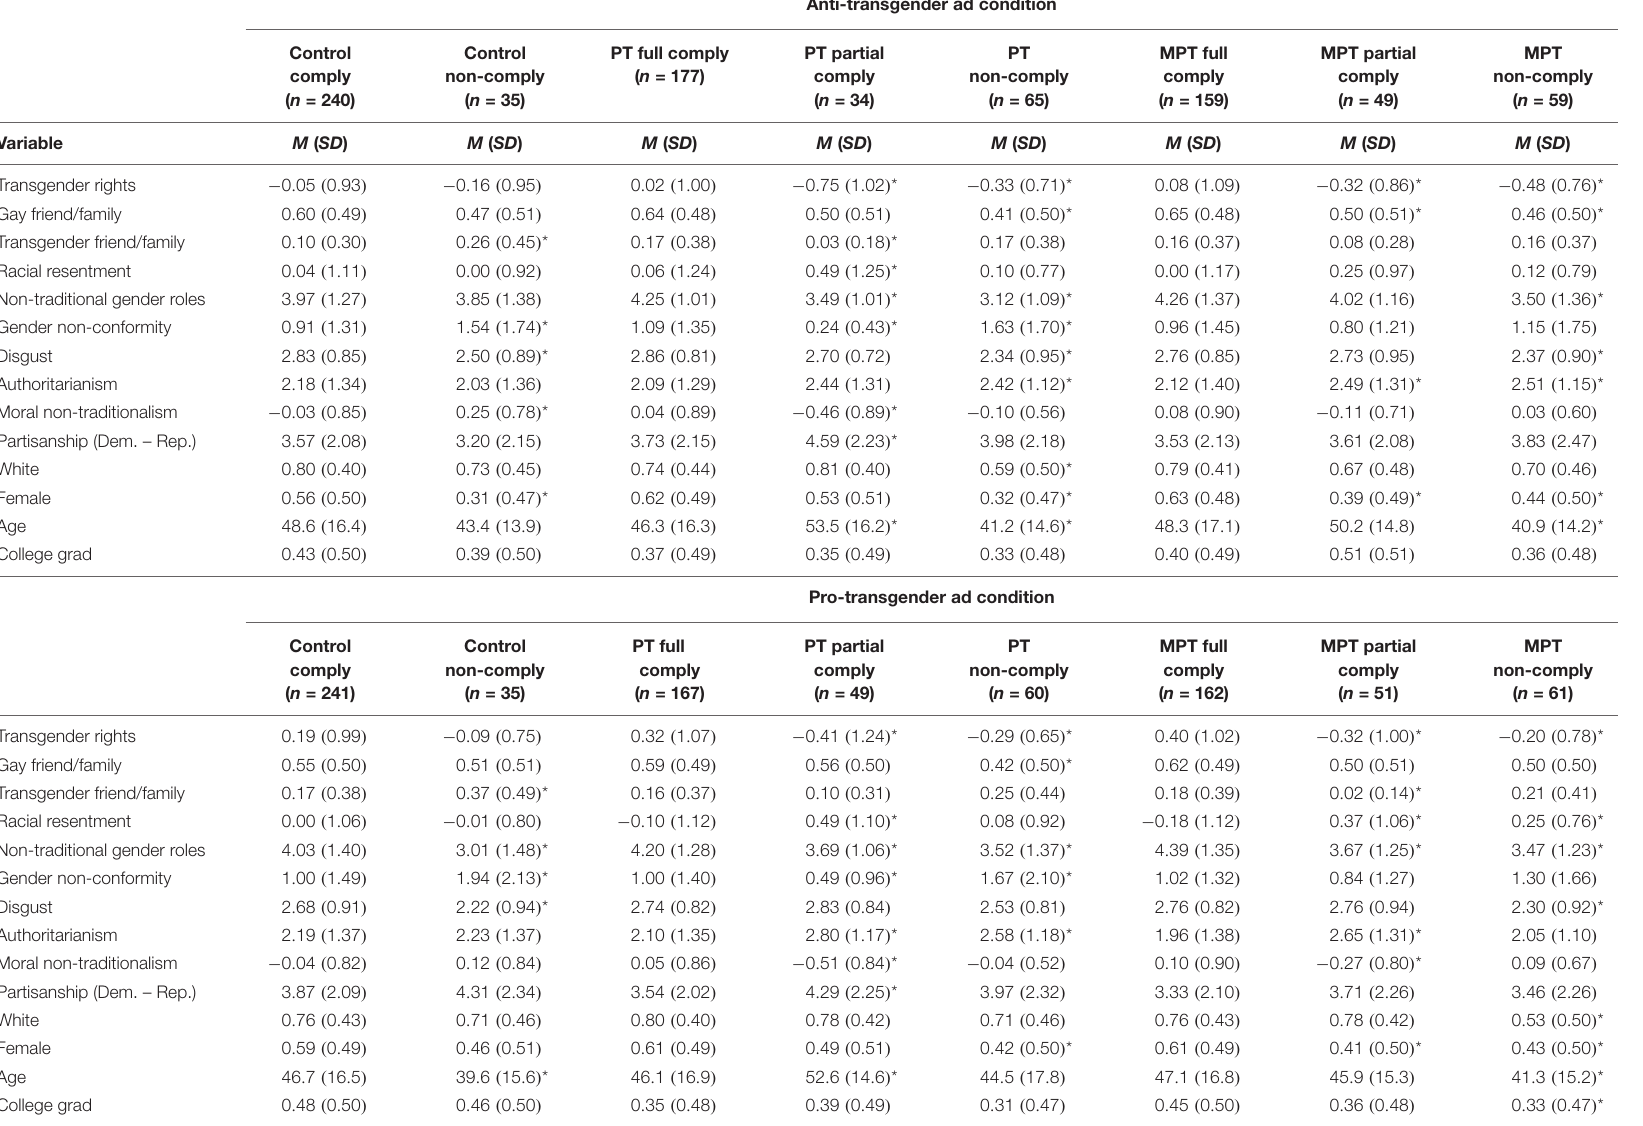
TABLE 5 | Comparing the traits of full compliers, partial compliers, and non-compliers (Study